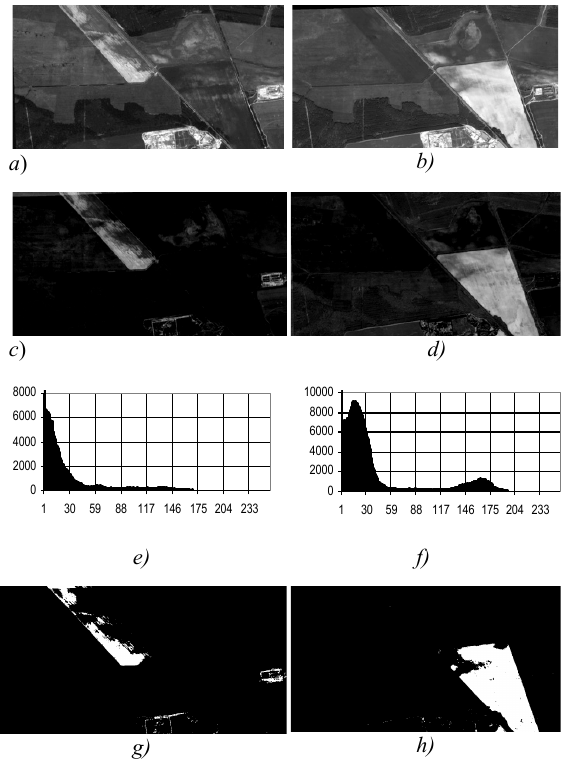
Figure 5 - Segmentation of changes: a ) and b ) fragments of multitemporal images, c ), d ) complementary pair of image changes, e ), f ) their histograms, g ), h ) segmentation of